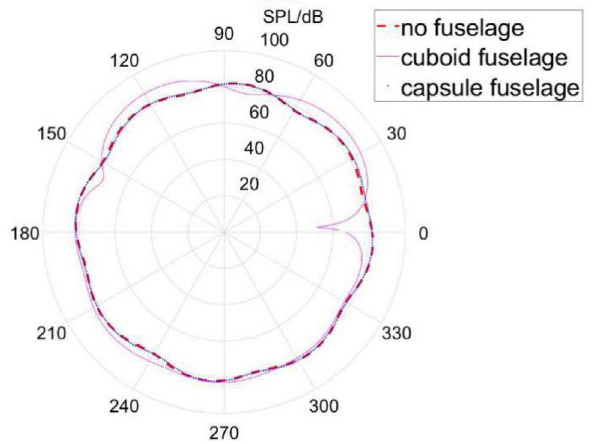
Figure 10. Helicopter model with capsule fuselage.